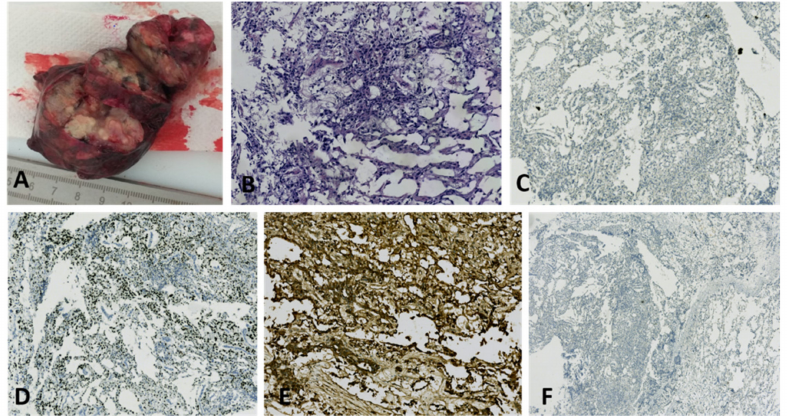
Figure 10. Yolk sac tumor in a 67-year-old patient: ( A ) Macroscopic aspect of a right ovarian tumor with extensive necrosis and hemorrhage; ( B ) High nuclear grade neoplasia with reticular architecture and microcysts (HE, × 100 magnification); ( C ) No immunohistochemical reaction for CD30 in tumor cells ( × 50 magnification); ( D ) Diffuse immunohistochemical reactivity for Sall4 in tumor cells ( × 50 magnification); ( E ) Diffuse intense immunohistochemical reactivity for AFP in tumor cells ( × 100 magnification); ( F ) No immunohistochemical reaction for OCT4 in tumor cells ( × 25 magnification). (Courtesy of Dr. M.